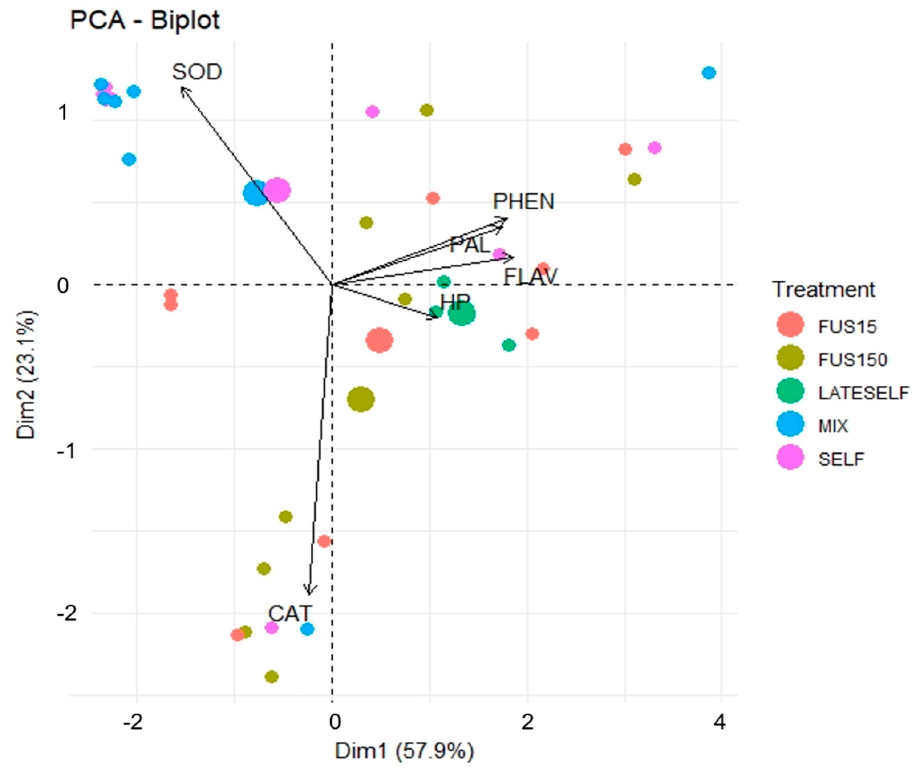
Figure 7. Dispersion of samples colored by treatment and the correlation of the evaluated variables for all treatments. Maximal variance explained by each principal component given in brackets.